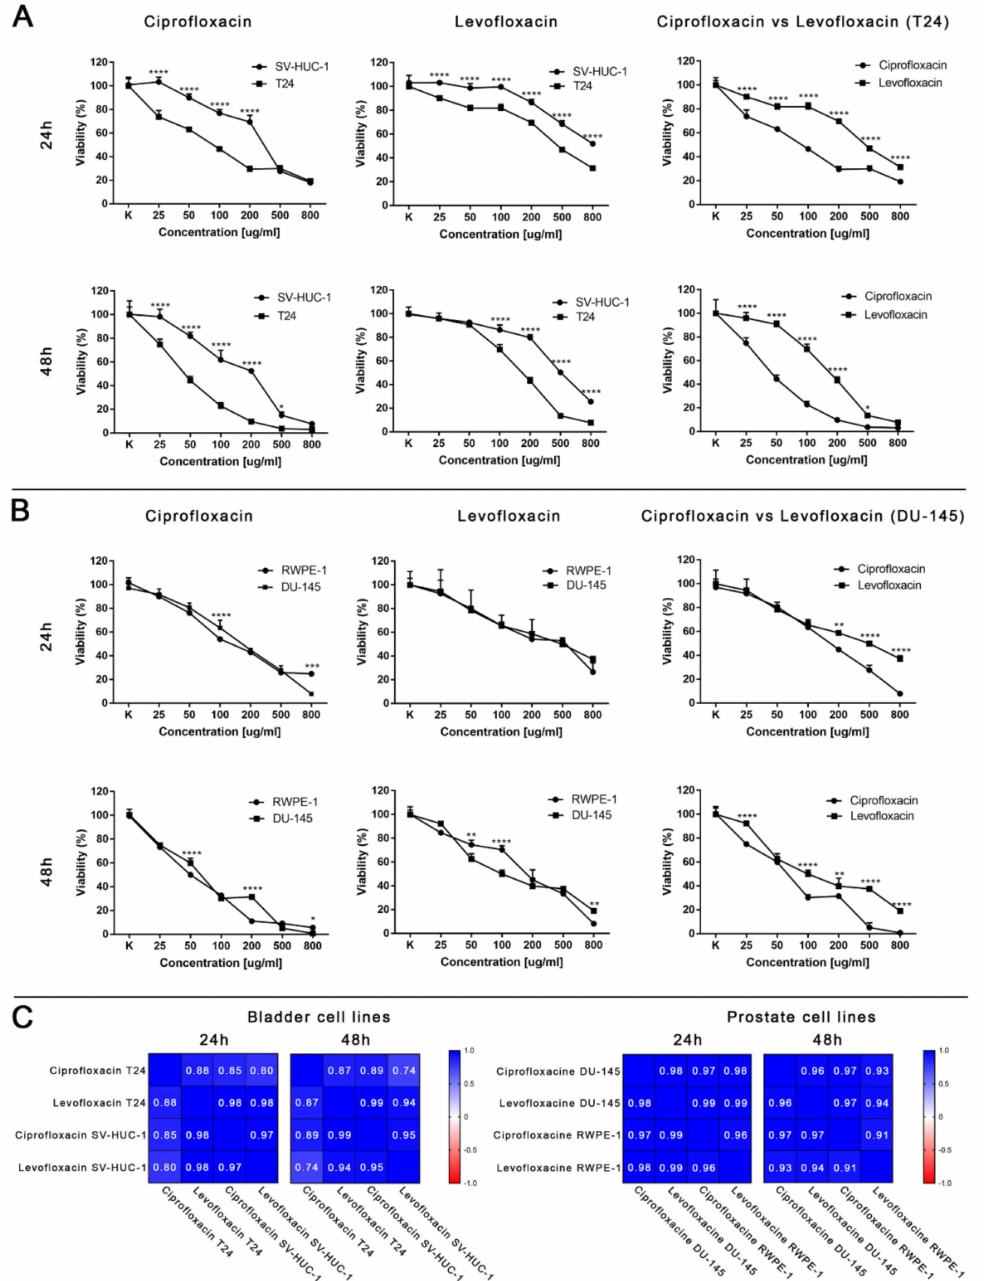
Figure 3. Cytotoxic properties of ciprofloxacin and levofloxacin. ( A )—Effect of both drugs on bladder cell lines. ( B )—Effect of both drugs on prostate cell lines. Significance was presented between two tested populations. ( C )—Pearson comparison of cytotoxic profiles of both drugs on bladder and prostate cell lines. Results obtained using MTT assay after 24 and 48 h incubation with both drugs. Ciprofloxacin and levofloxacin were more effective against cancer cell lines. Comparison of both drugs on the bladder cancer cell line showed the advantage of ciprofloxacin. SV-HUC-1—non-malignant human urothelium; T24—human bladder cancer; DU-145—human prostate cancer; RWPE-1—non-malignant human prostate epithelium; *— p ≤ 0.05; **— p ≤ 0.01; ****— p ≤